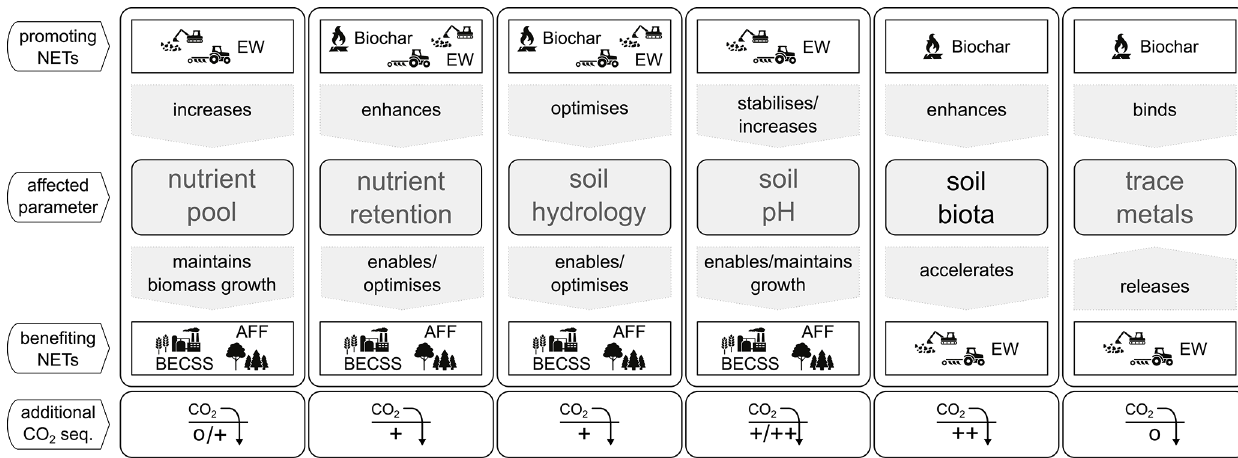
Figure 1. Overview of effects from combining land-based negative emission technologies (bioenergy production coupled with carbon capture and storage, BECCS; afforestation, AFF; Enhanced Weathering, EW; and biochar). The additional CO 2 sequestration is a qualitative estimate based on the author’s personal assessment. Technology symbols courtesy of William Lamb (MCC